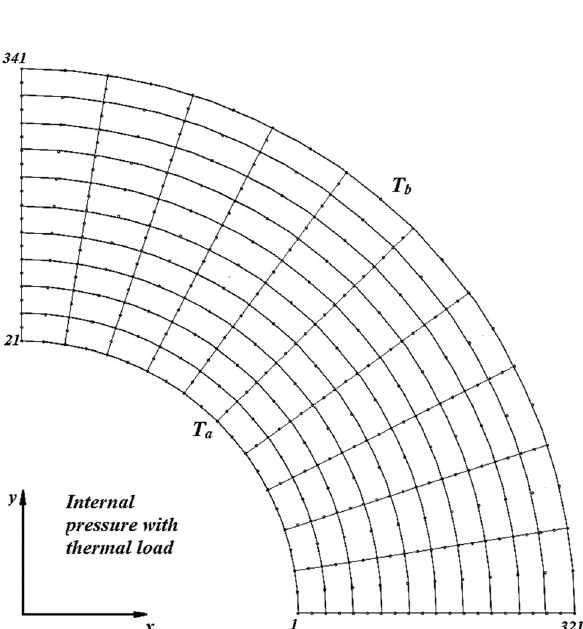
Figure 2: Mesh employed in the elastic – plastic analysis of a thick cylinder subjected to thermal and internal pressure loads under plane strain